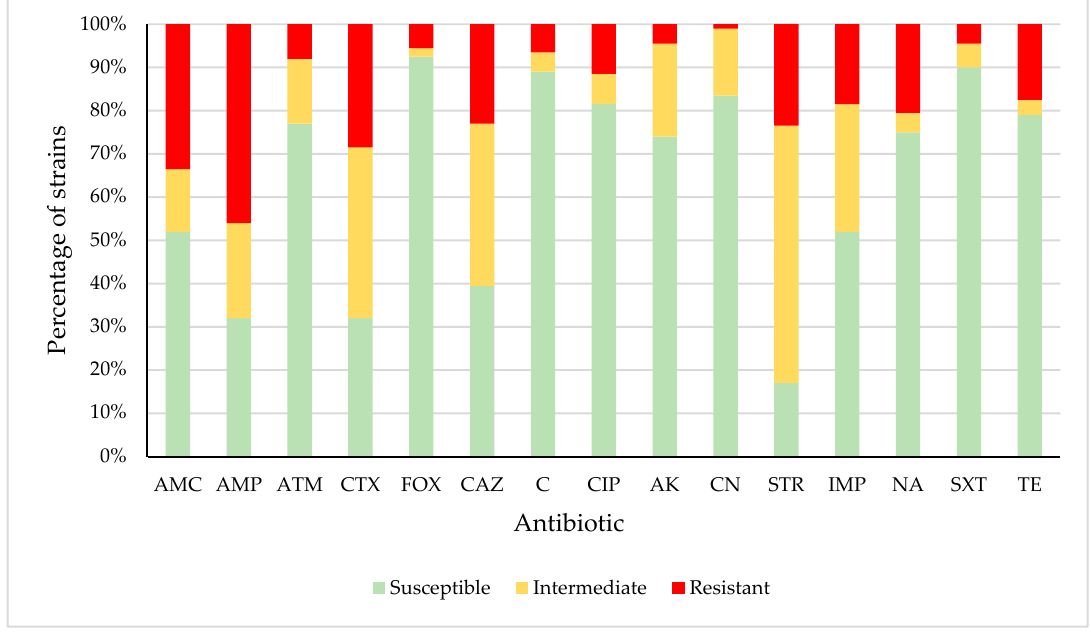
Figure 1. Percentage of Enterobacteriaceae strains susceptible, intermediate, or resistant to each antibiotic tested. Amoxicillin-clavulanic acid (AMC), ampicillin (AMP), aztreonam (ATM), cefotaxime (CTX), cefoxitin (FOX), ceftazidime (CAZ), chloramphenicol (C), ciprofloxacin (CIP), amikacin (AK), gentamicin (CN), streptomycin (STR), imipenem (IMP), nalidixic acid (NA), trimethoprim/sulfamethoxazole (SXT), and tetracycline (TE).